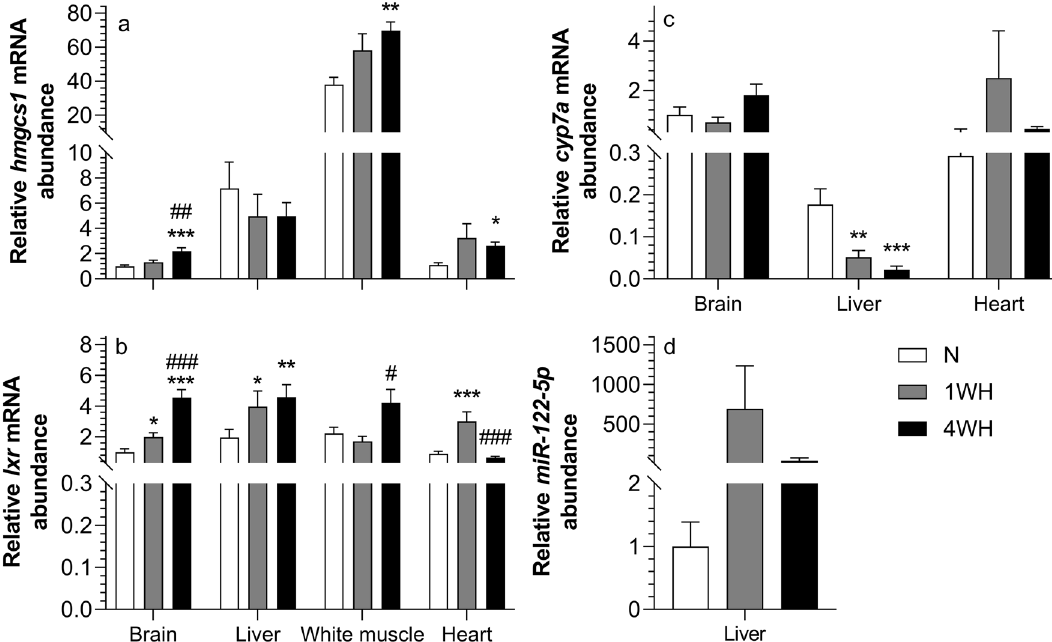
Figure 5. Relative transcript abundance of genes involved in cholesterol biosynthesis (( a ) hmgcs1 ; ( b ) lxr ; ( c ) cyp7a , ( d ) miRNA-122-5p ) in tissues of normoxic controls (N), 1-week hypoxic (1WH) and 4-week hypoxic (4WH) goldfish. Values are means ± standard error of the mean (s.e.m.); sample size = 7–12 per group. Differences between normoxia and chronic hypoxia are indicated as *( p < 0.05), **( p < 0.01) and ***( p < 0.001). Differences between 1 and 4WH are indicated as ##( p < 0.01) and ###( p <